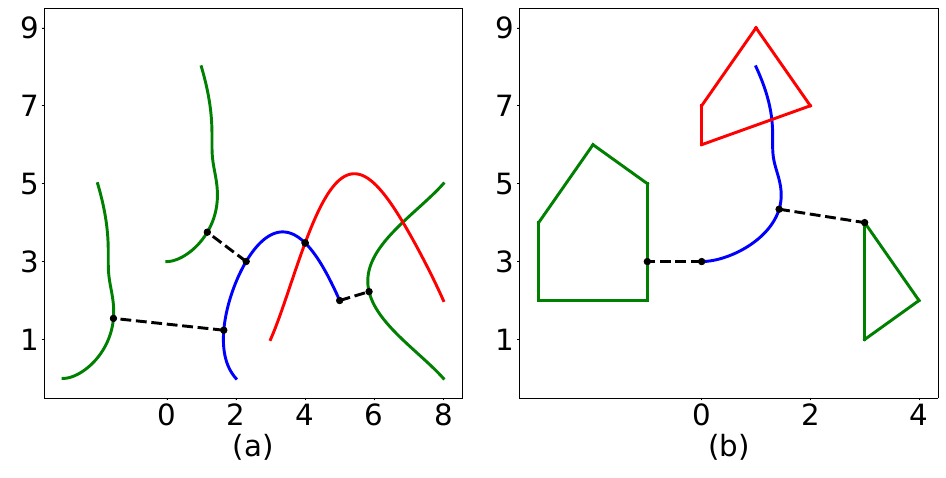
Figure 19. ( a ) Minimum distance between curves. ( b ) Minimum distance between a curve and a polygon. All distances are measured to the blue curve. A red curve or polygon indicates that a collision